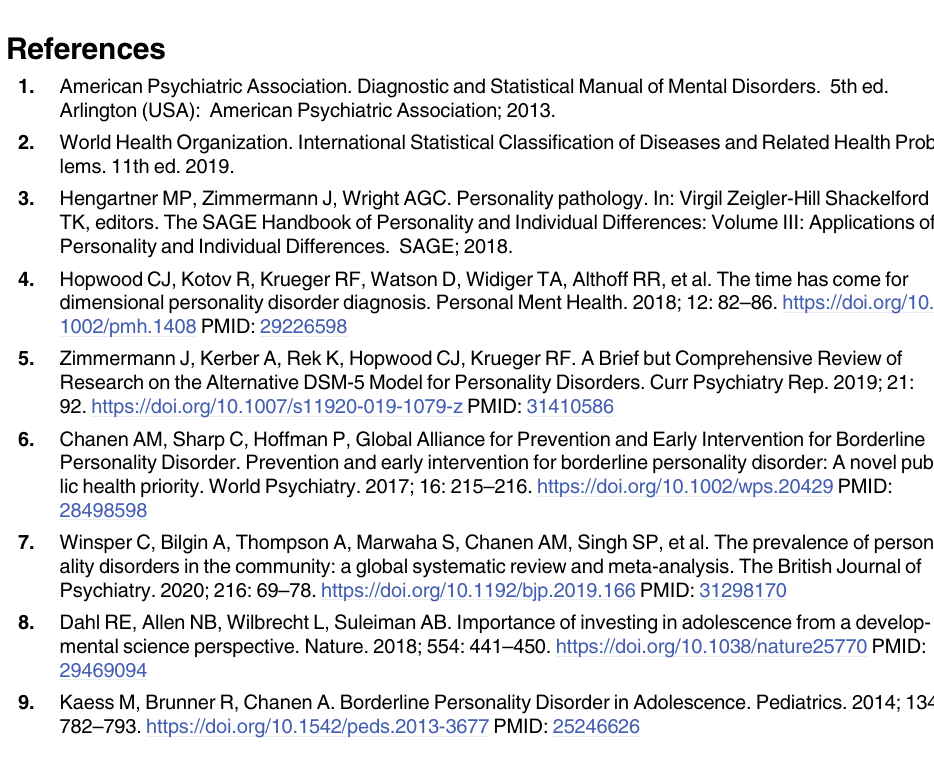
S2 Table. Energy consumption and CPU time for item permutation. S3 Table. Details of confirmatory factor